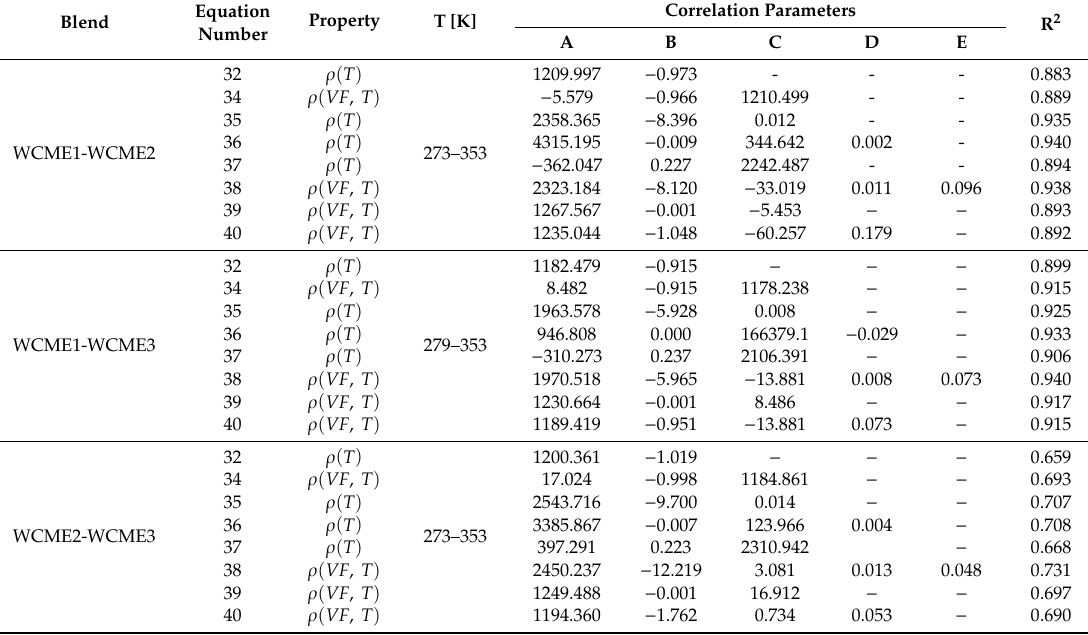
Table 10. Fraction-temperature correlations for biodiesel blends; correlation parameters and R 2 .